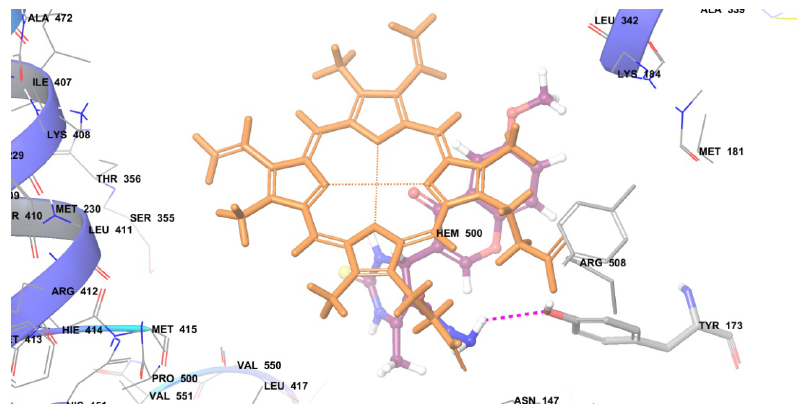
Figure 2. The docking pose of compound 6f in the active pocket of cytochrome P450 lanosterol 14 α -demethylase of C. albicans. (Light orange colored structure represents the heme co- factor, Pink bond represents the hydrogen bonding between ligand and receptor, Purple colored structure represents the molecule).